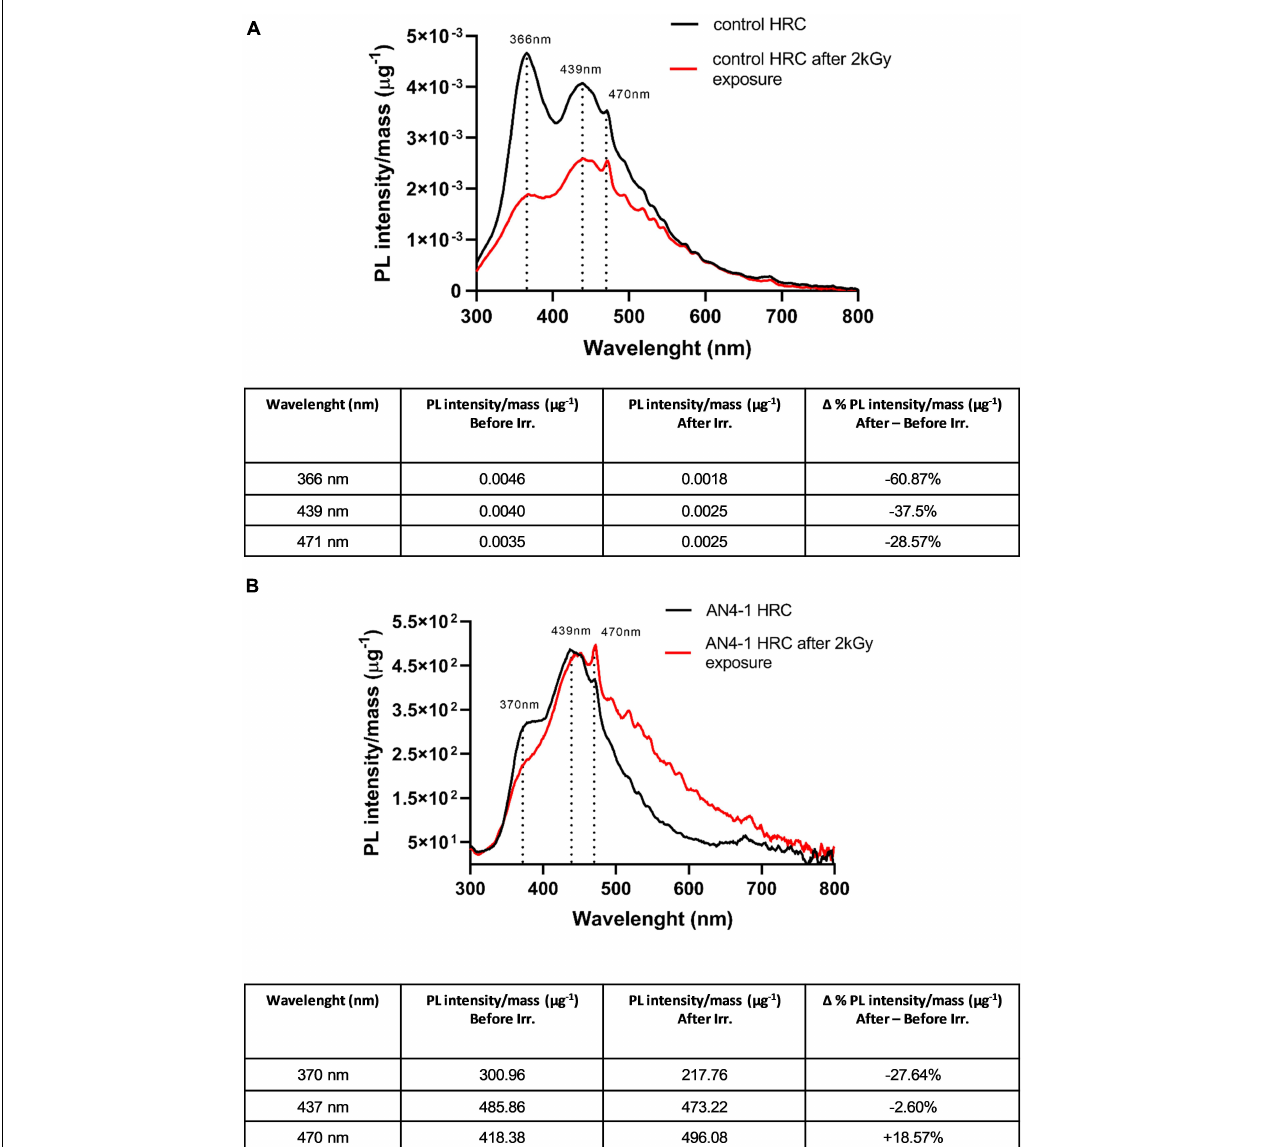
FIGURE 10 | Photoluminescence spectra of control (A) and AN4-1 (B) HRCs and related mass-normalized emission intensities (tables) before and after 2 kGy gamma irradiation. Main peaks refer to tryptophan (370 nm), its degradation products kynurenine and 3-hydroxykynurenine (439 and 470 nm), and carbamate anion (470